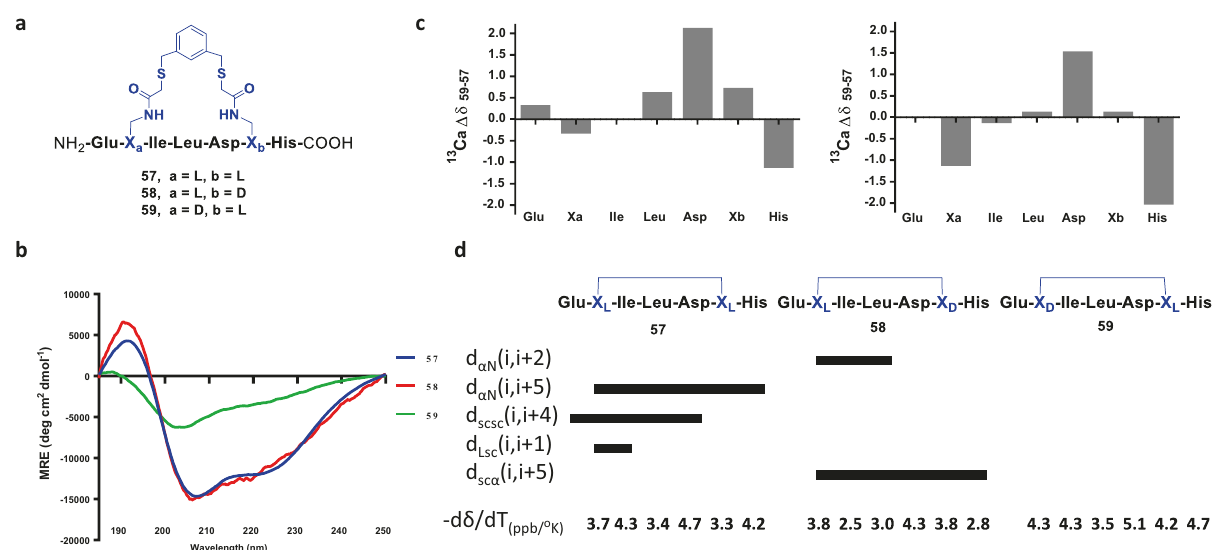
Fig. 4 Peptide NMR spectra comparison among peptides 57 – 59 that are shortened representatives of the best FTDR-stapled Axin peptide analogues (39, 51, 55). a Chemical structures of peptides 57 – 59 . b Circular dichroism (CD) spectra of 57 – 59 . c Plots of the 13 C α chemical shift differences ( 13 C α Δδ 13 C α chemical shift differences ( 13 C α Δδ 58 – 57 ) between peptide 58 and 57 , and 59 – 57 ) between peptide 59 and 57 , respectively. d Summary of the observed nonsequential NOE connectivity and temperature coef fi cients of the NH amide protons ( Δδ / Δ T) of peptides 57 – 59 . “ α ” : proton on the α carbon; “ N ” : proton on the amide bond; “ sc ” : proton on the side chain; “ L ” : proton on the staple linker. Coupling residues X L /X D and 1,3-benzenedimethanethiol linker are highlighted in blue.